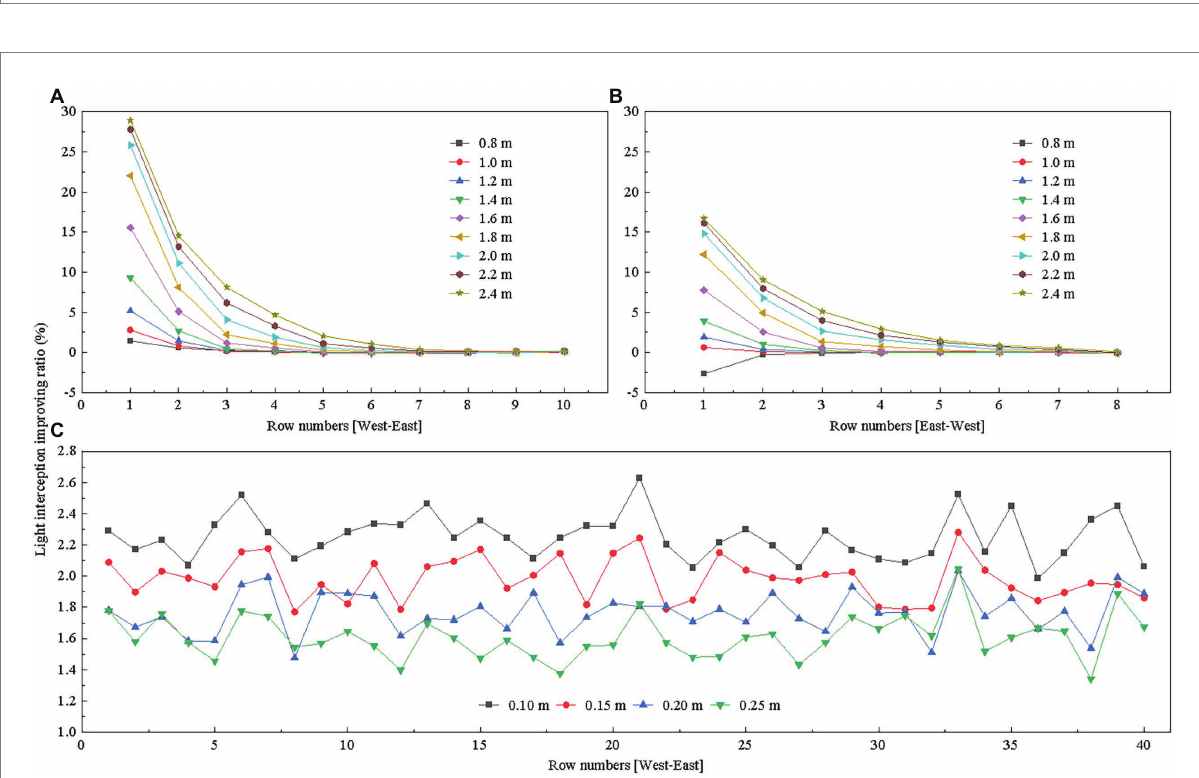
FIGURE 10 Effects of reflective film height on tomato canopy light interception: (A) west side, (B) east side of the greenhouse, and (C) under the canopy. The reflective films on the west and east sides of the greenhouse were placed on the ground, and the height of the reflective films refers to the length of the reflective films in the vertical direction; the reflective films below the canopy were placed near the plant roots, and the height of the reflective films refers to the height from the